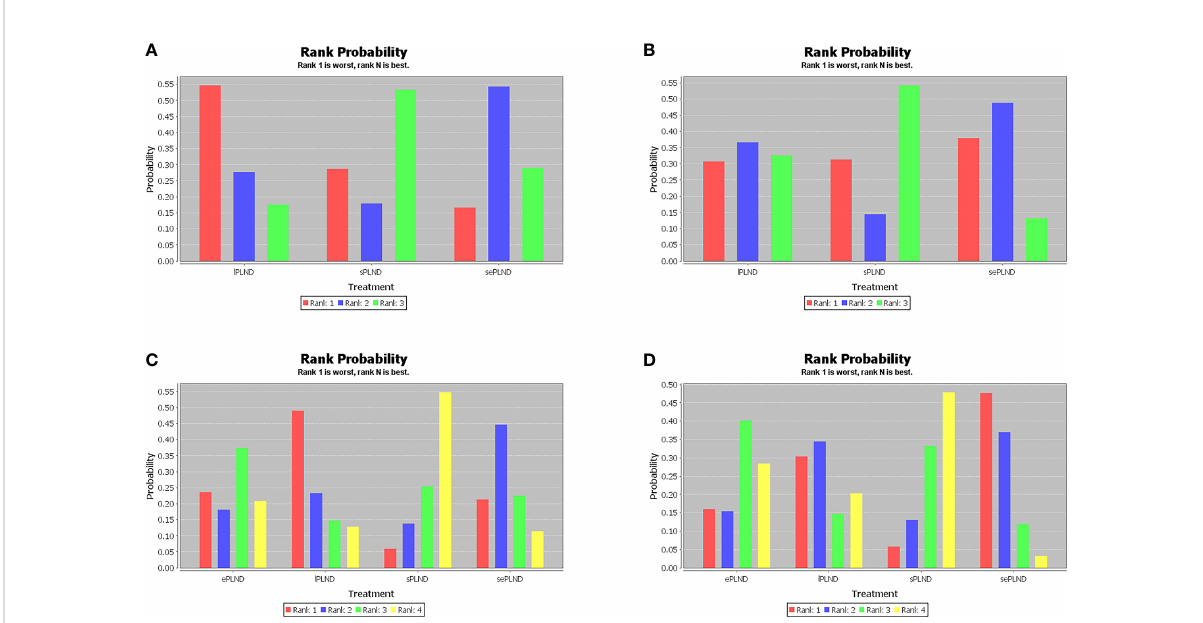
FIGURE 10 (A) Rank probabilities of each PLND template in the fi rst, second, third and fourth place among three PLND templates for early Clavien-Dindo grade 5 complications rates. (B) Rank probabilities of each PLND template in the fi rst, second, third and fourth place among three PLND templates for late Clavien-Dindo grade 5 complications rates. (C) Rank probabilities of each PLND template in the fi rst, second, third and fourth place among four PLND templates for early Clavien-Dindo grade 3-4 complications rates. (D) Rank probabilities of each PLND template in the fi rst, second, third and fourth place among four PLND templates for late Clavien-Dindo grade 3-4 complications rates. lPLND, limited pelvic lymph node dissection. sPLND, standard pelvic lymph node dissection. ePLND, extended pelvic lymph node dissection. sePLND, super-extended pelvic lymph node